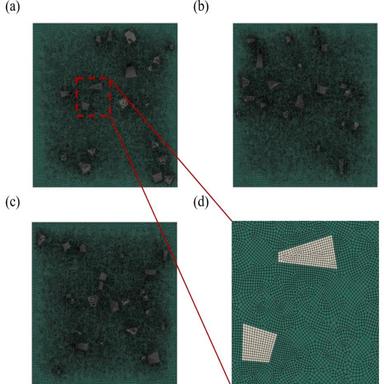
RVEs sketch considering the precipitates: (a) Model I, (b) Model II, (c) Model III and (d) refined mesh around precipitates.